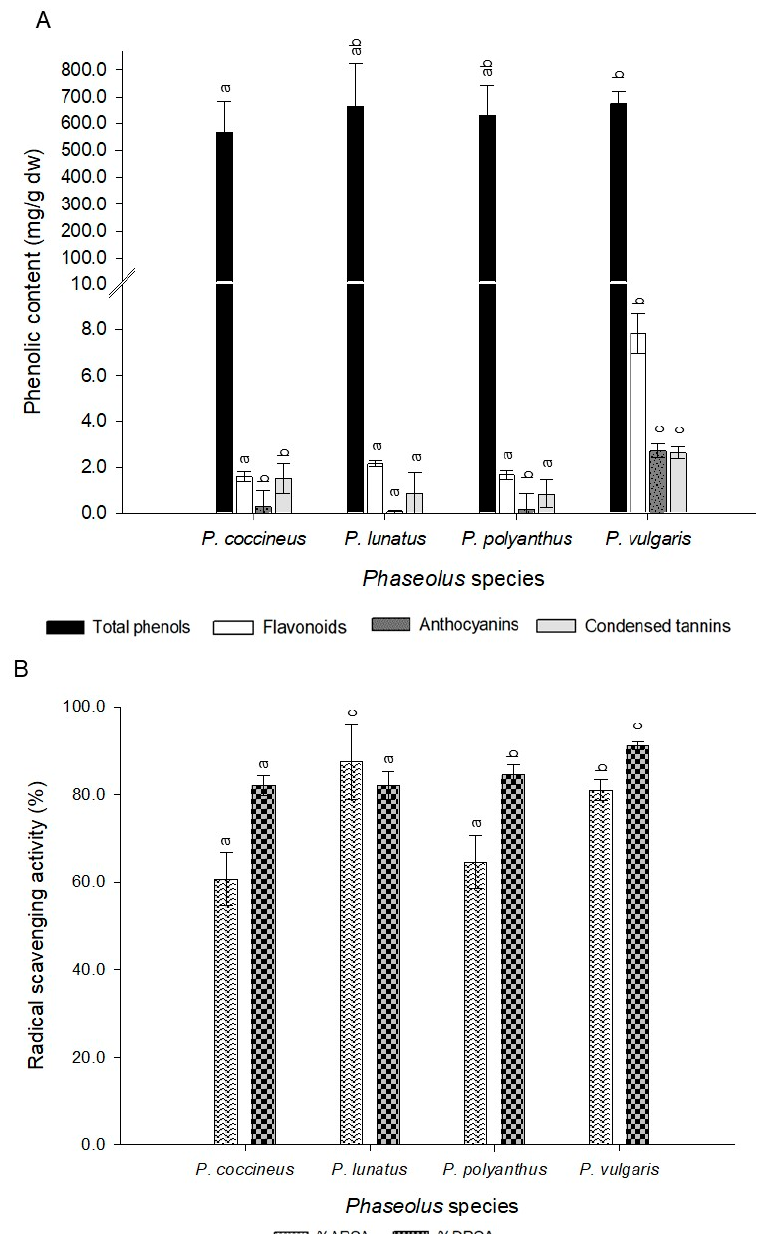
Figure 3. Phenolic compounds ( A ) and antioxidant activity ( B ) of bean varieties by Phaseolus species. Mean values ± SD with different letters indicate statistically significant differences according to Tukey’ test ( p < 0.05). Abbreviations: ARSA = ABTS Radical Scavenging Activity, DRSA = DPPH Radical Scavenging Activity.